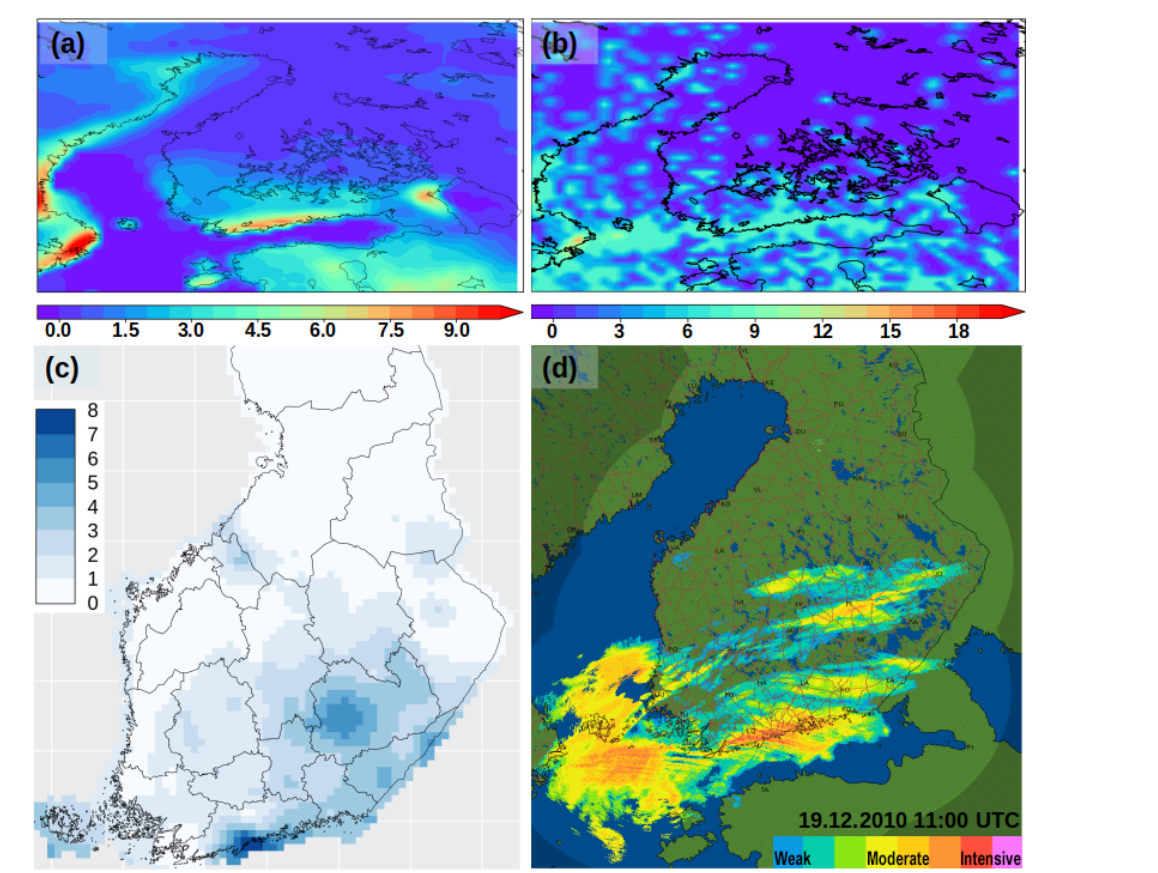
Figure A5. Precipitation in 19 December 2010 from different databases. (a) Accumulated snowfall from RCA4 (mmd − 1 ), (b) total precipi- tation from RCA4 (mmd − 1 ), (c) total precipitation from FMIClimGrid (mmd − 1 ), (d) radar reflectivity factor (dBZ) image at